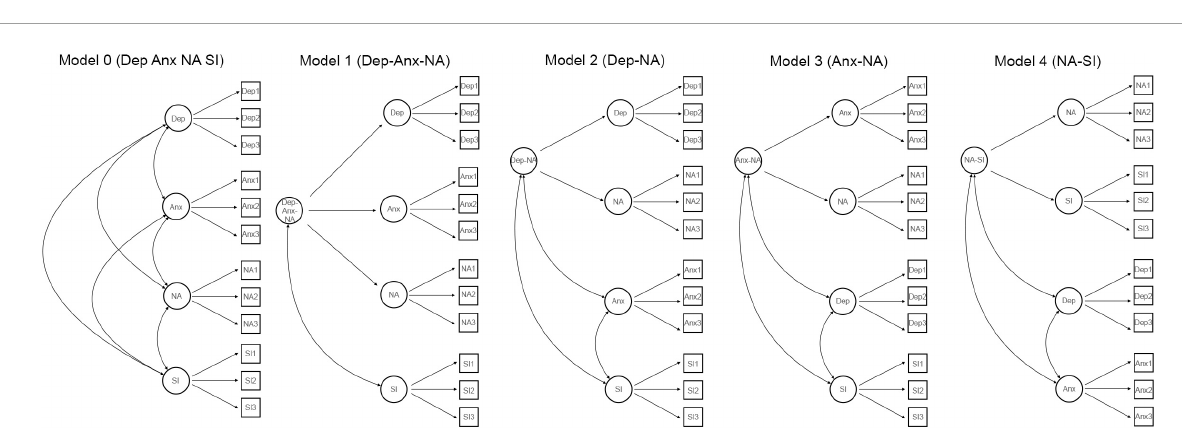
comorbidity assessed by the Charlson comorbidity score (Charlson et al., 1987) at the time of the index CHD event was collected from hospital records. Information about body weight,